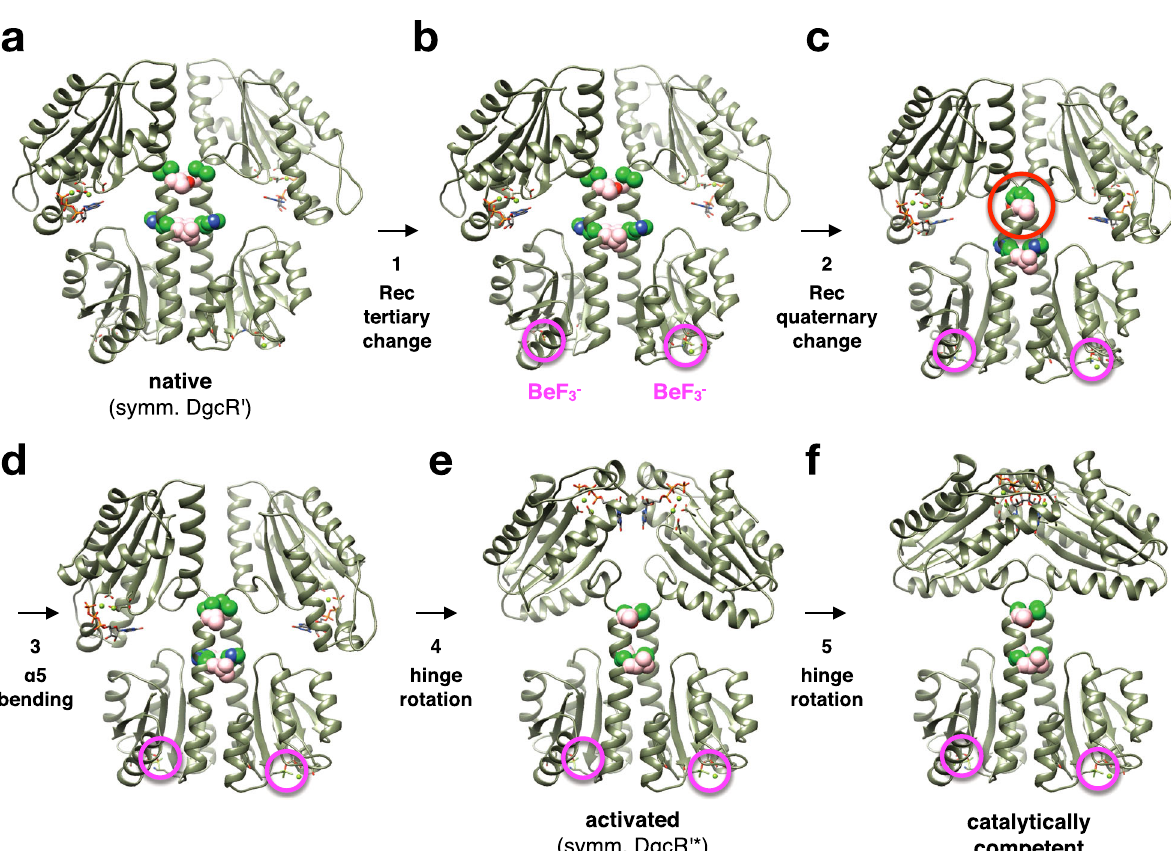
Fig. 7 Structural transitions in DgcR upon activation. Rec pseudo-phosphorylation induces steps 1 to 3, which are followed by GGDEF hinge motions of steps 4 and 5 to attain the catalytically competent state. See also Supplementary Movies 1 and 2. The structures are represented as in Fig. 1b, c, but with the residues of the conditional coiled-coil contacts shown as CPK models (residues in d and e position are shown is pink and green). The beryllo fl uoride moieties of the dimer are highlighted by magenta circles. a DgcR ’ , symmetrized version with both GGDEF domains in B-chain orientation (cf. with Fig. 1b). b As in a , but with beryllo fl uoride-induced tertiary change applied to Rec rigid_body 1 (see Fig. 3). c As in b , but with quaternary change applied to Rec domains. Note the clash between the C-terminal ends of the coiled-coil (red circle). d As in c , but with Rec dimer as found in symmetrized version of DgcR ’ *. e Symmetrized version of DgcR ’ * (cf. with Fig. 1c). f Model of catalytically competent DgcR as in Fig. (Supplementary Table 1). There are three symmetric dimers in the asymmetric unit. Each dimer shows a Rec stalk in native conformation and the two GGDEF domains have their active sites facing outwards. Dimeric c-di-GMP is cross-linking the domains by interacting with the R206xxD209 motif of one subunit and R163 * from α 0 ’ of the other subunit (Fig. 8b). Owing to sym- metry, there are two isologous cross-links within the DGC dimer.